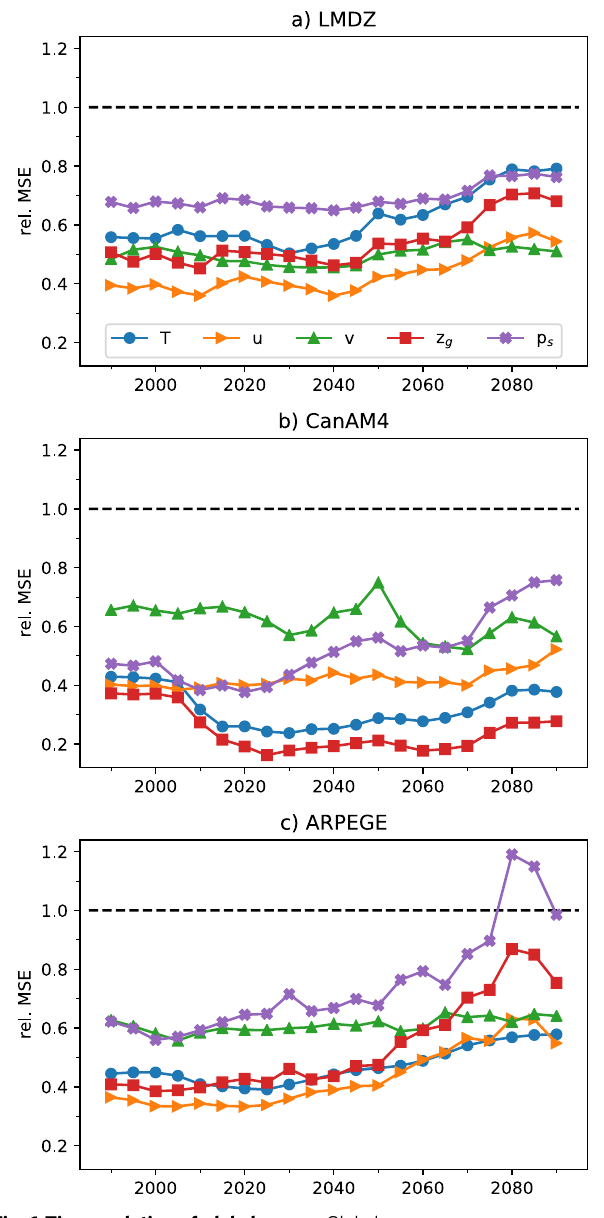
Fig. 1 Time evolution of global errors. Global average mean square error (MSE) of the corrected AGCM runs relative to the uncorrected reference runs for 20-year running means of fundamental atmospheric circulation variables (air temperature T , zonal wind speed u , meridional wind speed v , geopotential height z g , and surface air pressure p s (over areas with surface height below 1000 m)). MSE of T , u , v , and z g are averaged over four representative pressure levels (850, 700, 500, and 300 hPa (200 hPa for LMDZ)). a LMDZ; b CanAM4; c